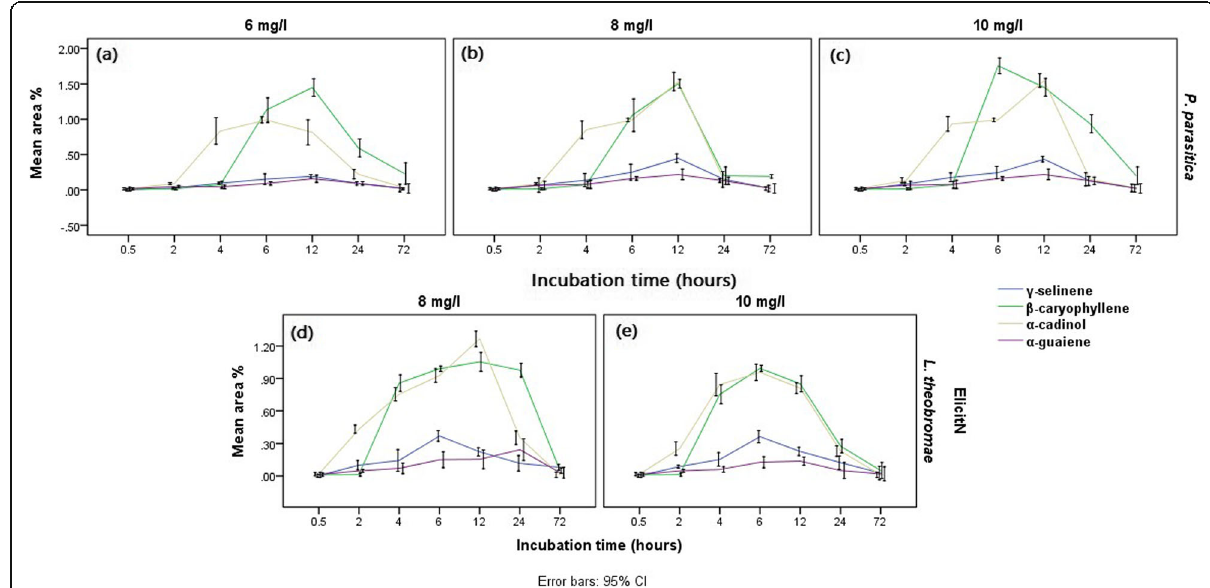
Fig. 12 Mean area percentages of sesquiterpenes produced in G. walla cell suspension under ( a ) 6 mg/l, ( b ) 8 mg/l, ( c ) 10 mg/l P. parasitica and ( d ) 8 mg/l, ( e ) 10 mg/l L.